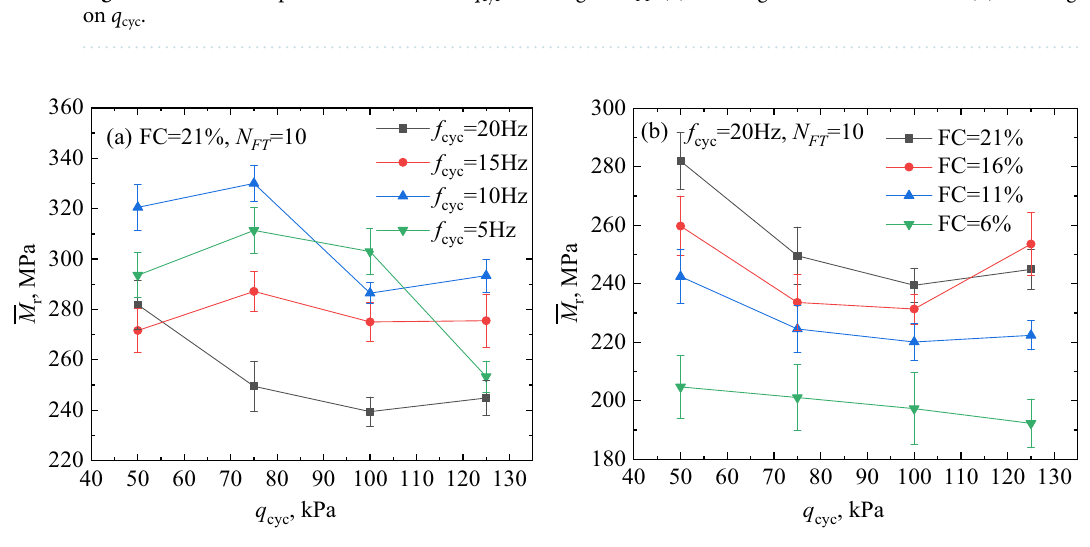
Figure 7. Relationship between M r and q cyc , ( a ) focusing on f cyc and ( b ) focusing on